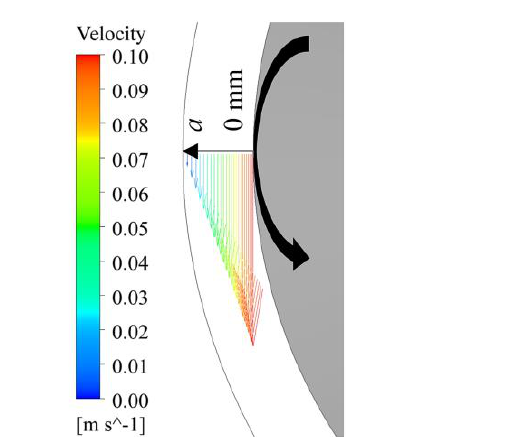
Fig. 11. The oil flow velocity profile in the gap for the spindle speeds s 1 = 14 min -1 and s 2 = 110 min -1 .